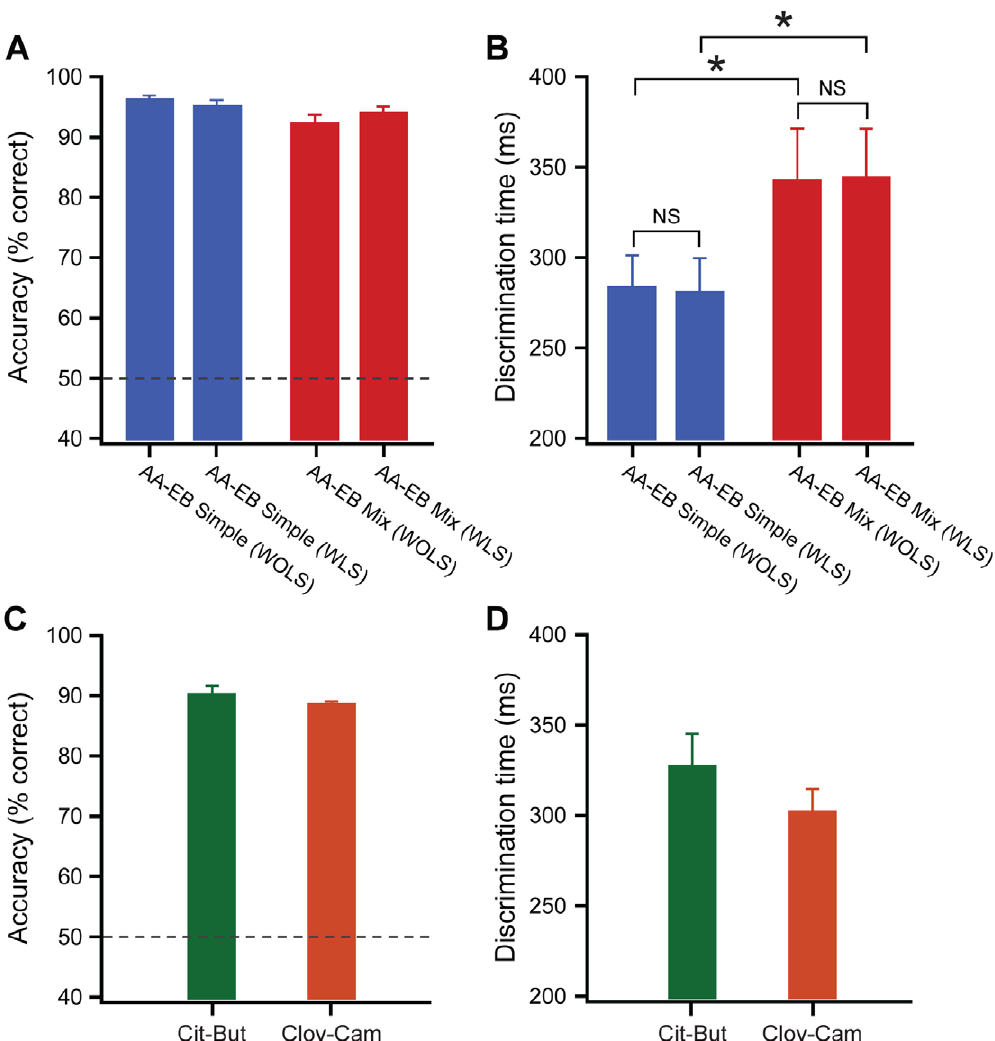
Figure 3. Rapid and stimulus dependent discrimination times are observed in a go/no-go olfactory task under head-restrained conditions. ( A–B ) Determination of discrimination times in presence (WLS) and absence of warning stimuli (WOLS): No influence of warning stimuli (light + sound) in the DT measurements. (WOLS=Without Light and Sound, WLS=With Light and Sound). ( A ) Accuracies measured for simple and complex odor tasks of amyl acetate and ethyl butyrate, 300 trial blocks from which DT is calculated (for AA vs EB, blue bars, n=8 mice, average 6 sem; for binary mixtures, red bars, n=8 mice, average 6 sem). ( B ) DTs were increased for complex odors compared to simple odors even in the presence and absence of warning stimuli (for AA vs EB, blue bars, n=8 mice, average 6 sem; for binary mixtures, red bars, n=8 mice, average 6 sem. ( C–D ) Accuracy and discrimination times measured for cit vs but and clov vs cam, 300 trial blocks from which DT is calculated (for cit vs but, green bar and clov vs cam, brown bar, n=8 mice, average 6 sem). Dotted lines in (A) and (C) indicate chance